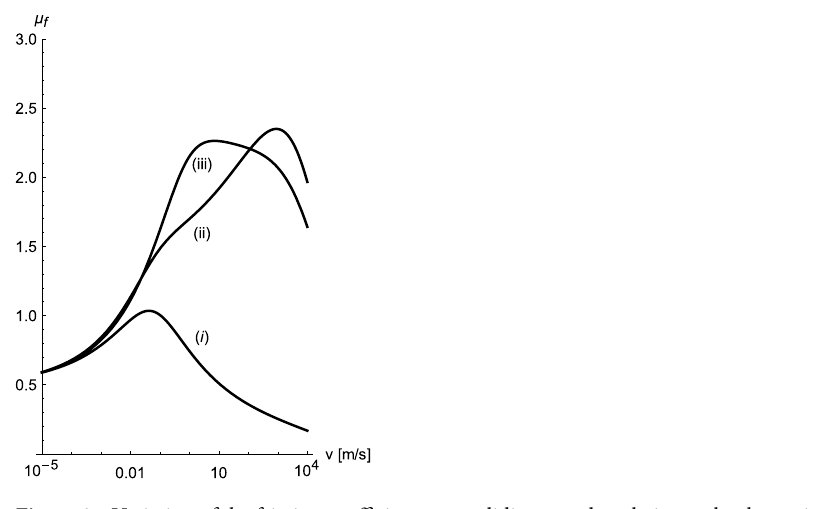
Figure 3. Variation of the friction coefficient µ f vs. sliding speed v relative to the theoretical curve in the previous figure for P = 1 bar. (i) H = 0.8 (ii) H = 0.89 (iii) previous τ times